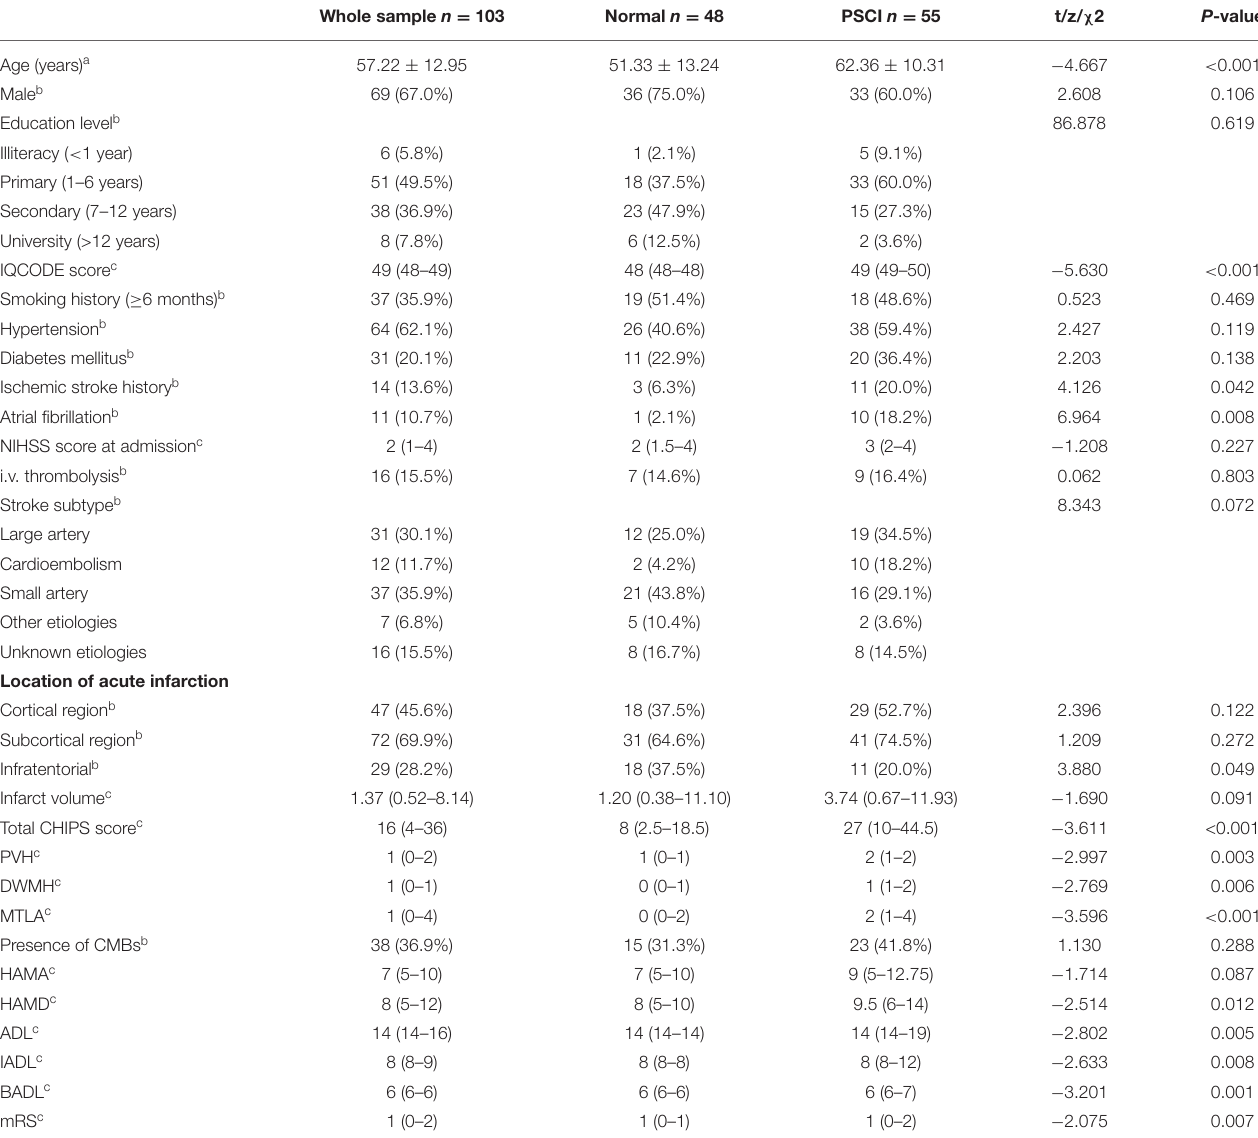
TABLE 1 | Comparisons of demographic, clinical, and imaging characteristics between patients with normal cognition and those with PSCI. Whole sample n = 103 Normal n = 48 PSCI n = 55 t/z/ χ